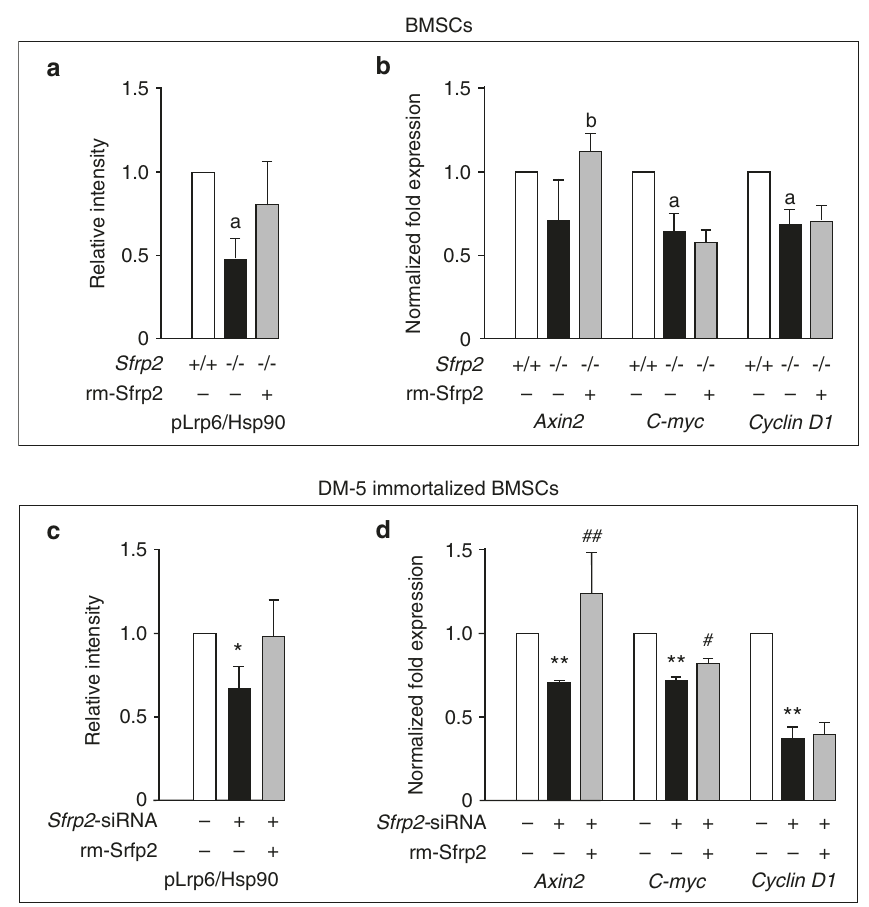
Fig. 6 Sfrp2 de fi ciency reduces Wnt signaling in murine BMSC/SSCs. a , b BMSCs/SSCs from WT and Sfrp2 KO mice were cultured, depleted of hematopoietic cells and treated with 1 μ g·mL − 1 rm-Sfrp2 or vehicle. C,D DM5 cells were transfected with scrambled (Con-siRNA) or Sfrp2 -siRNA and treated with 1 μ g·mL − 1 rm-Sfrp2 or vehicle. a , c Lrp6-Ser1490 phosphorylation, as measured by western blot densitometry versus HSP90, was decreased in Sfrp2-de fi cient cultures and trended to normalize 5 h after the addition of rm-Sfrp2. It is possible that the reported levels of pLrp6 (Ser1490) also include pLrp5 (ser1493), as per the manufacturer ’ s description. The antibody used is expected to also detect this highly similar epitope. b , d Expression of Wnt target genes Axin2 , C-myc and Cyclin D1 (vs. Gapdh ) was decreased in Sfrp2 -de fi cient cultures and partially normalized 24 h after the addition of rm-Sfrp2. Data are presented as the mean of three or more independent experiments ± SD. a P < 0.05 vs. WT BMSCs/SSCs, b P < 0.05 vs. Sfrp2 KO BMSCs/SSCs. * P < 0.05; ** P < 0.01 vs. Con - siRNA treated cells; # P < 0.05, ## P < 0.01 vs. Sfrp2-siRNA treated